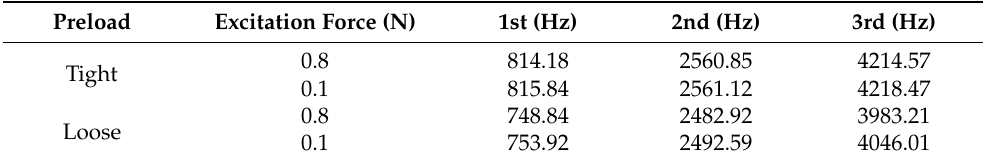
Table 3. First three order frequencies of the threaded tube (40_2) under four conditions (source elaborated by